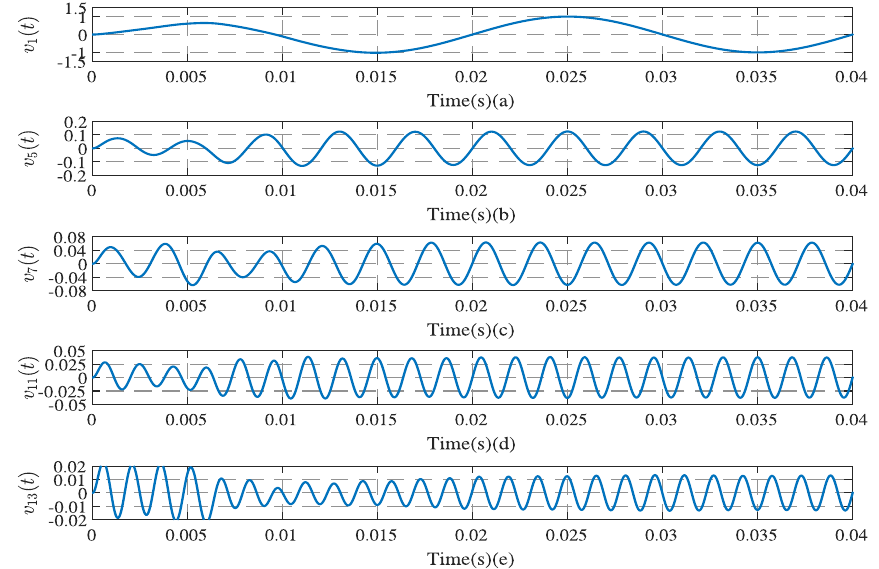
Figure 3. Observation chart for each harmonic: ( a ) 1st, ( b ) 5th, ( c ) 7th, ( d ) 11th, and ( e ) 13th.